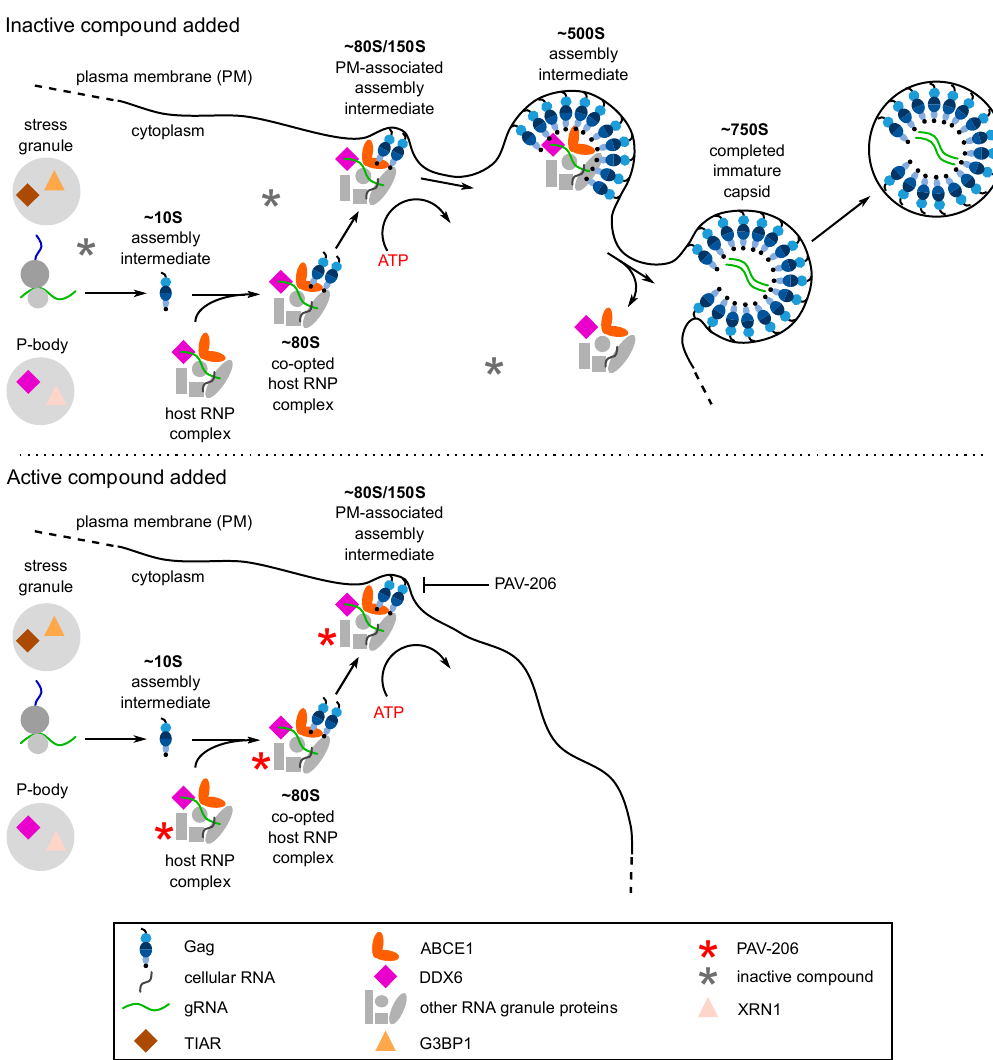
Figure 6. PAV-206 appears to inhibit HIV-1 replication by reducing formation of the ~500S assembly intermediate, most likely by binding to a host protein in assembly intermediates. The top panel shows that the assembly pathway is unaffected by an inactive control compound. For details of events in this pathway, see the Figure 3A legend. The bottom panel is based on recent findings [29] and shows that addition of PAV-206 or one of its active analogs results in association of the small molecule (red asterisk) with an as yet unidentified host protein in the assembly intermediates, leading to a reduction in the formation of the final ~500S assembly intermediate and little to no virus production.